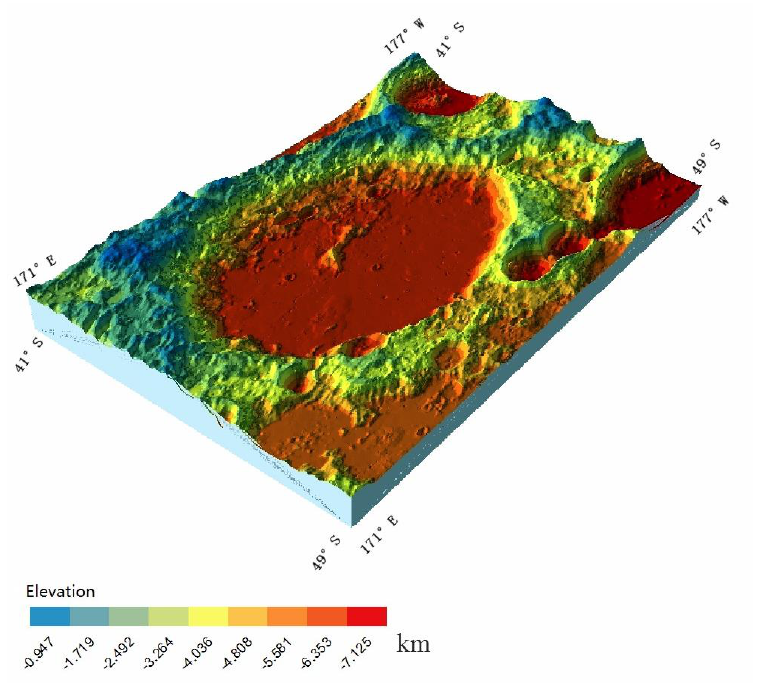
Figure4. Von Karman's three-dimensional elevation model